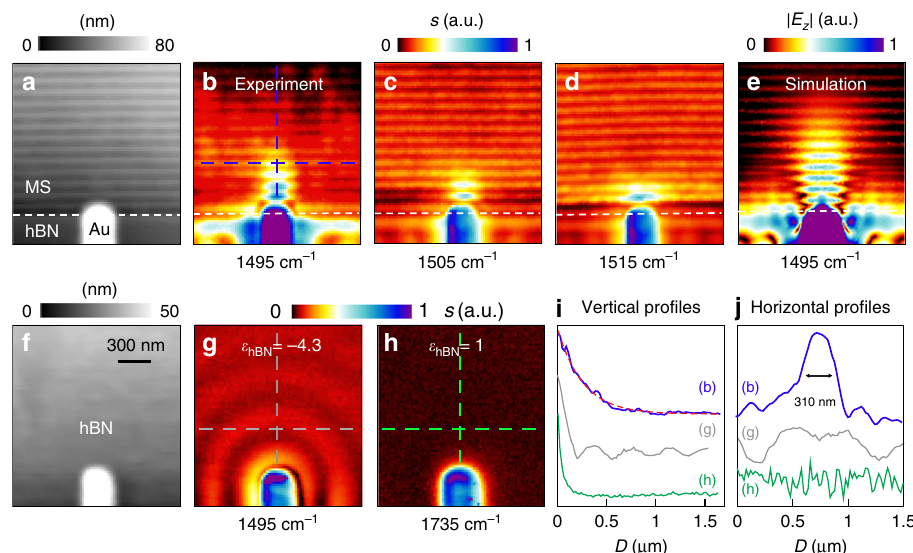
Fig. 4 Real-space imaging of polariton canalization in a hBN metasurface. a Topography of the sample. b – d Experimental near- fi eld distribution of antenna-launched elliptical polaritons on the metasurface at three different frequencies. White dashed lines mark the boundary of the metasurface. e Simulated near- fi eld distribution of the antenna-launched canalization EPhPs on the metasurface. f , g , h Topography and experimental near- fi eld images (at two different frequencies) for the case of an antenna located on an unpatterned area of the same hBN fl ake. i Blue line shows the near- fi eld pro fi le taken from the image shown in the panel ( b ) along the vertical dashed blue line, which can be fi tted by an exponential decay (dashed red line). Gray line shows the near- fi eld pro fi le taken from g along the vertical dashed gray line. Green line shows the near- fi eld pro fi le taken from h along the vertical dashed green line. j Horizontal near- fi eld line pro fi les taken from b , g , and h along the horizontal dashed lines,